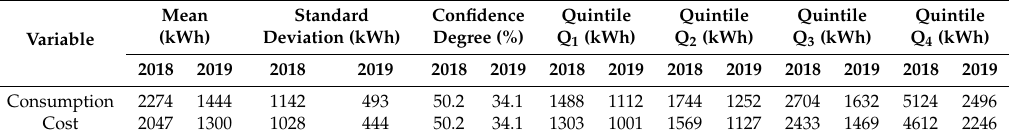
Table 4. Comparison on the statistical results obtained from 2018 to 2019.